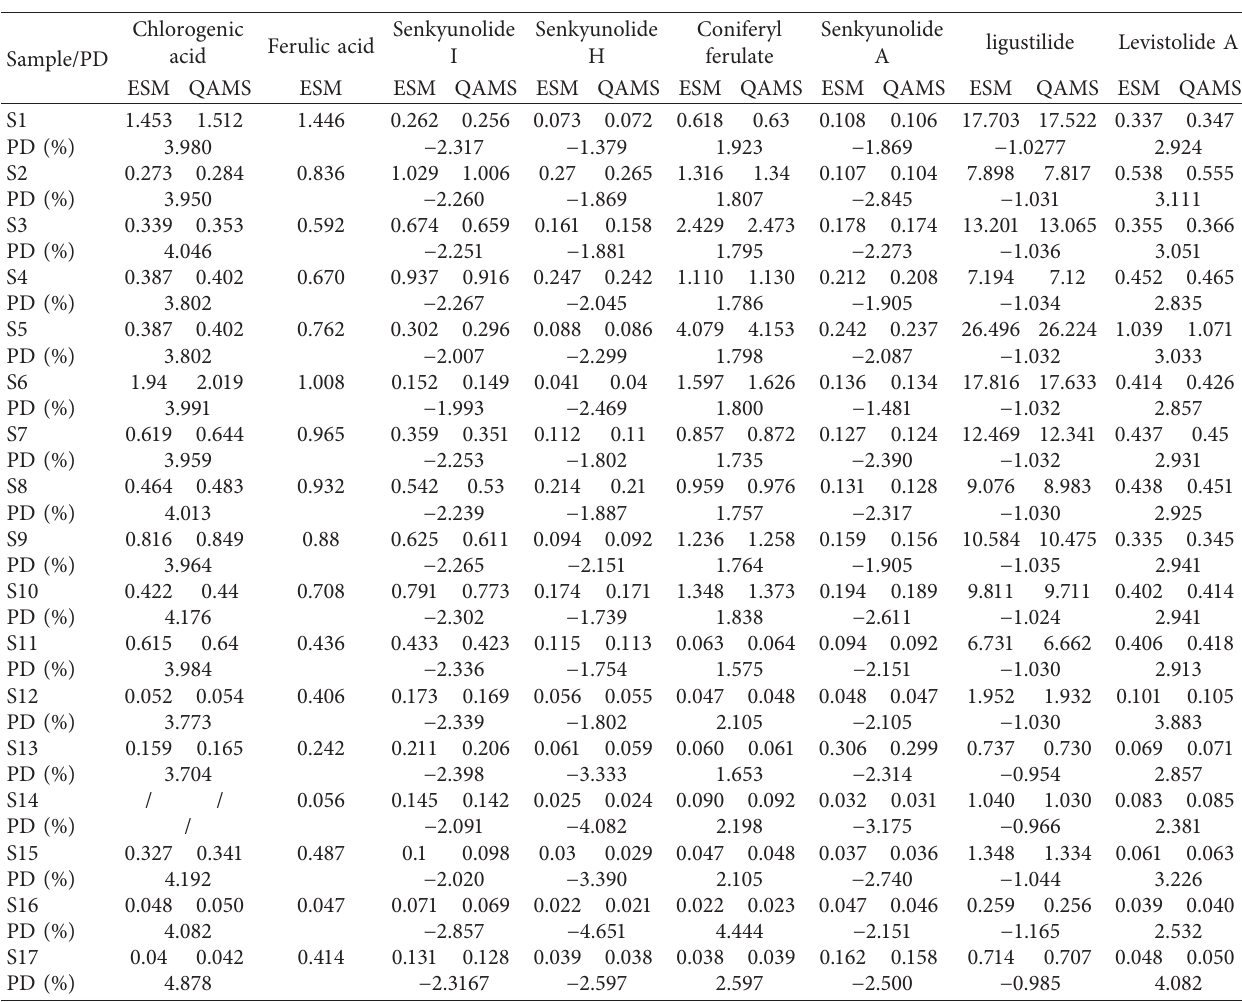
Table 4: Content of 8 components in 10 batches of ASR and its 12 kinds of preparations determined by QAMS and ESM